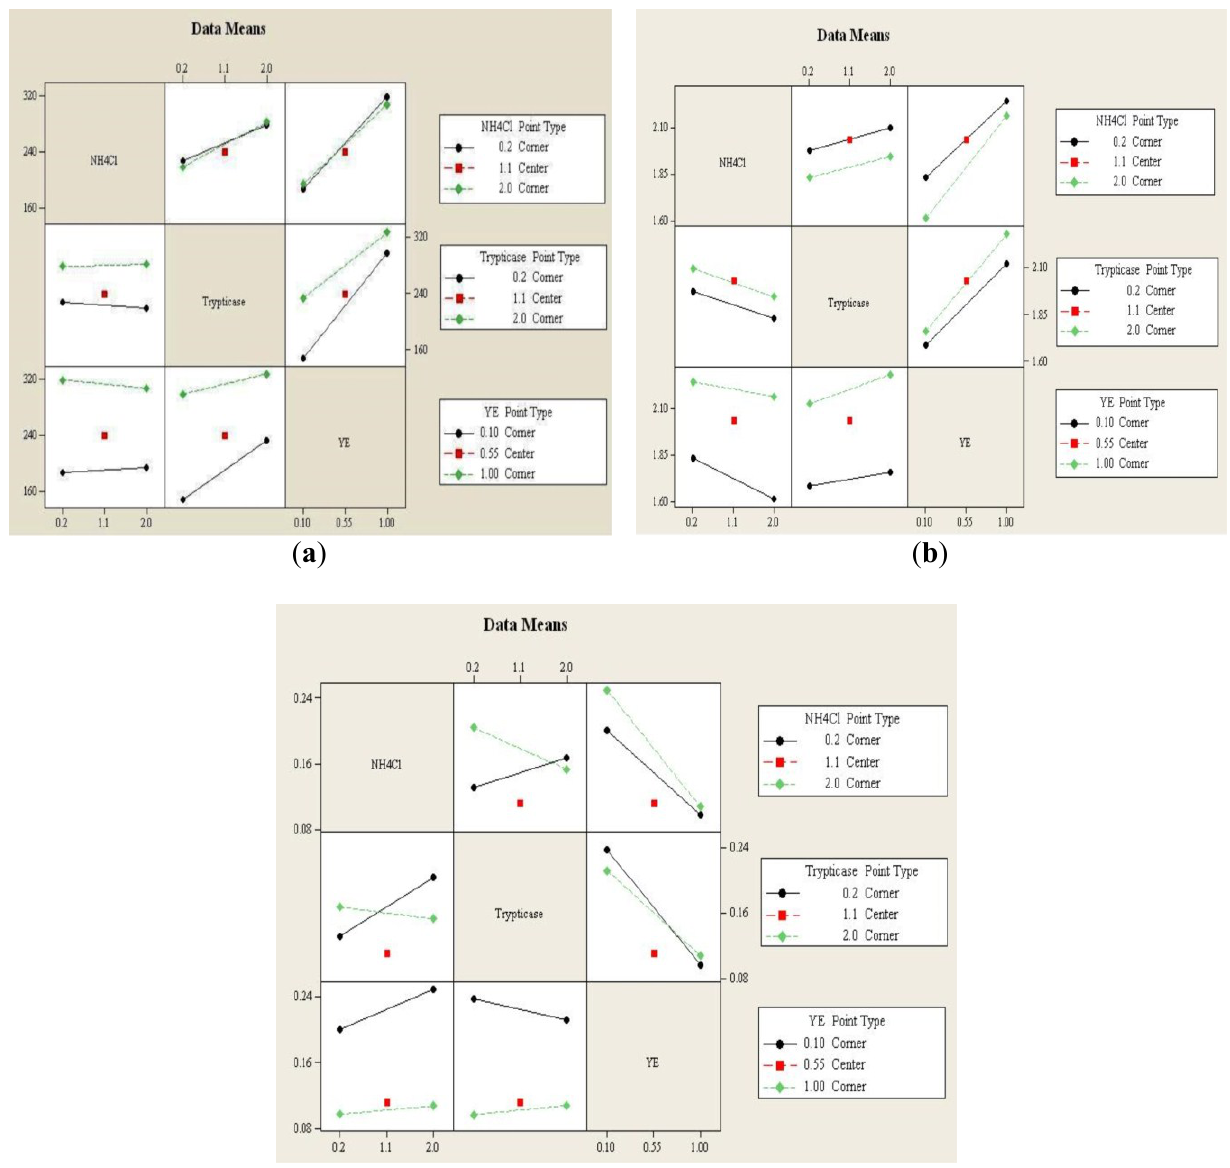
Figure 3. Interaction effects plots for ( a ) Biomass, ( b ) Acetic acid and ( c )